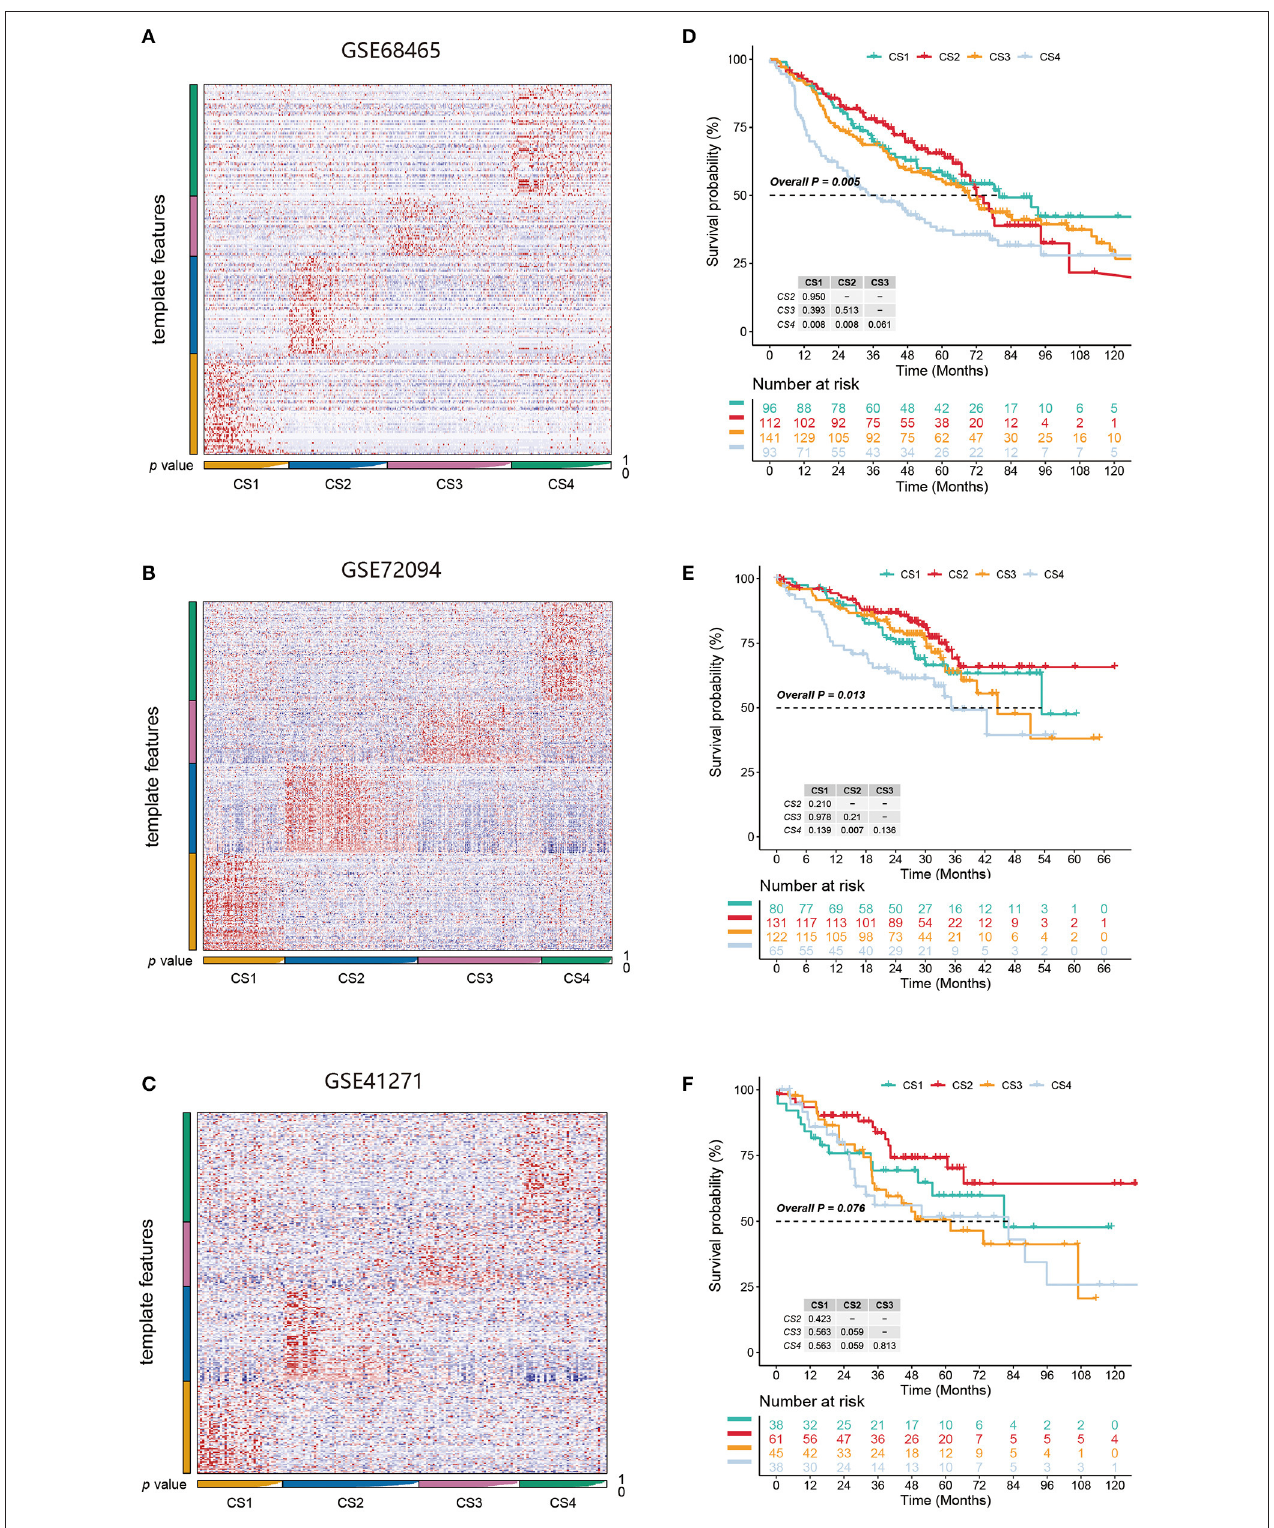
FIGURE 6 | (A–C) Heatmap of NTP in three external cohorts GSE68465, GSE72094, and GSE41271 using subtype-specific upregulated biomarkers identified from the LUAD cohort. (D–F) Kaplan-Meier survival curve of the predicted four subtypes of three external cohorts.